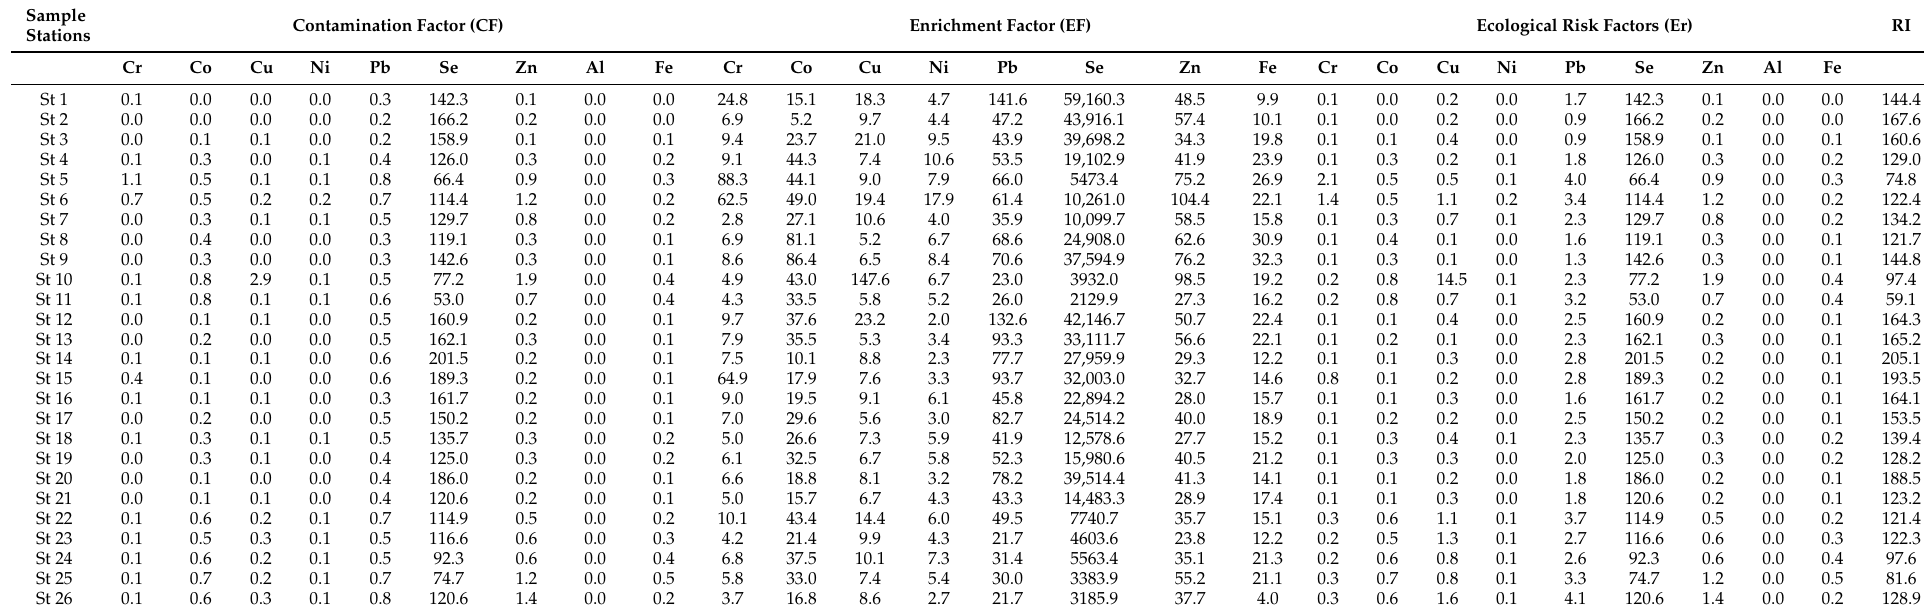
Table 4. Potentially toxic element pollution